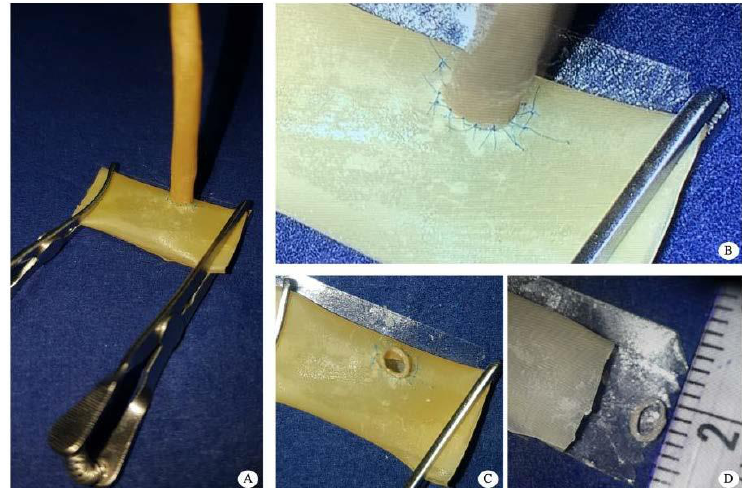
Figure 3. ( A ) naked-eye appearance of the end-to-side anastomosis setting at the end of the exercise; ( B ) picture taken through the 3D glasses: screen view at the end of the anastomosis; ( C ) naked-eye appearance of the anastomotic site at the patency check; ( D ) caliber of the two vessels used for end- to-side anastomosis.